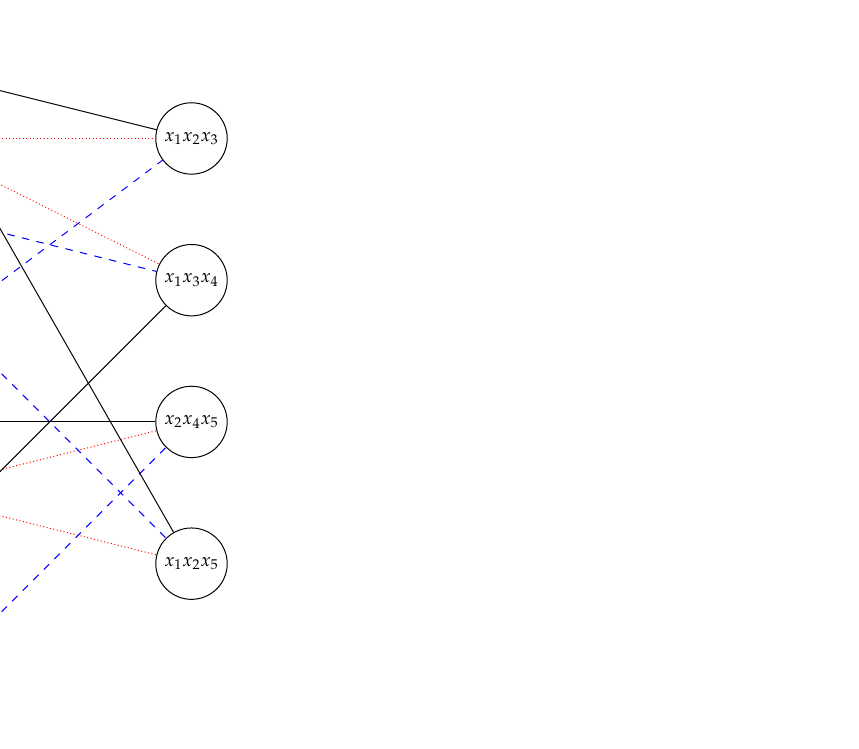
Figure 7. The covering graph for Example 1. We have emphasized all three different coverings by coloring the edges differently for each covering. They are the red dotted, blue dashed, and black solid